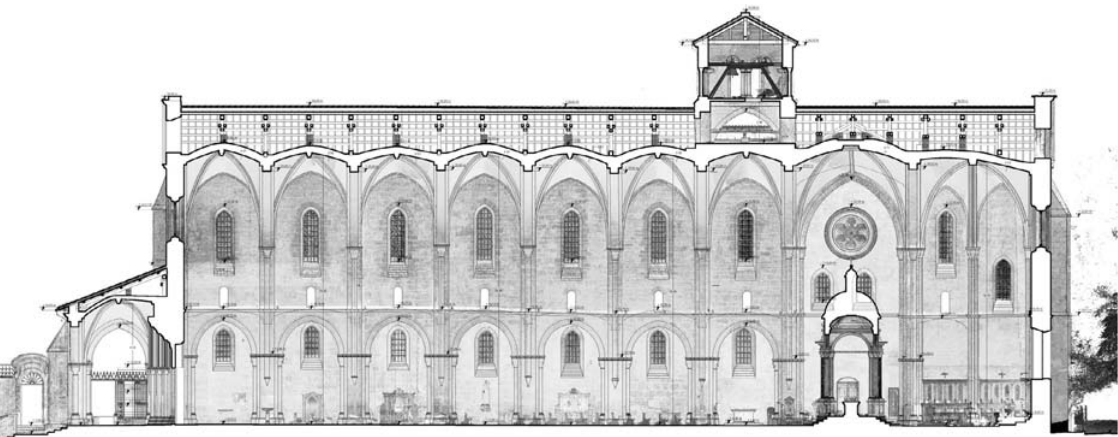
Figure 1a. The Abbey of Casamari (Veroli): Longitudinal section, Survey elaboration (2014)